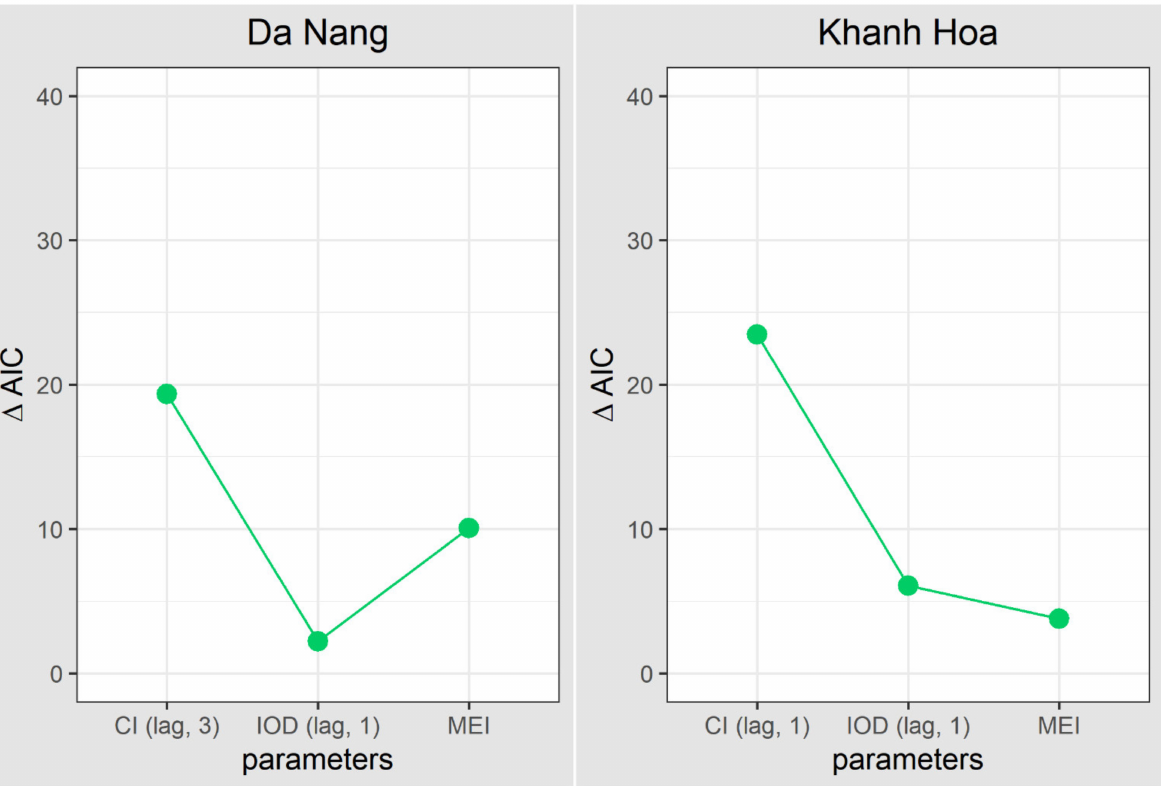
Figure 6. Importance of model parameters (Table 3) in Da Nang and Khanh Hoa. IOD—Indian Ocean Dipole; MEI—multivariate ENSO index; CI—Container Index; AIC—Akaike information